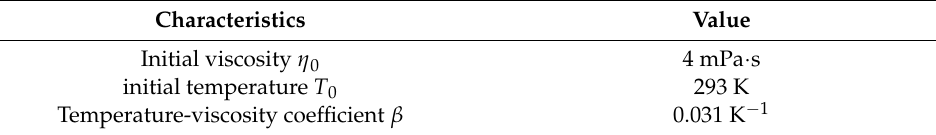
Table 3. Parameters of